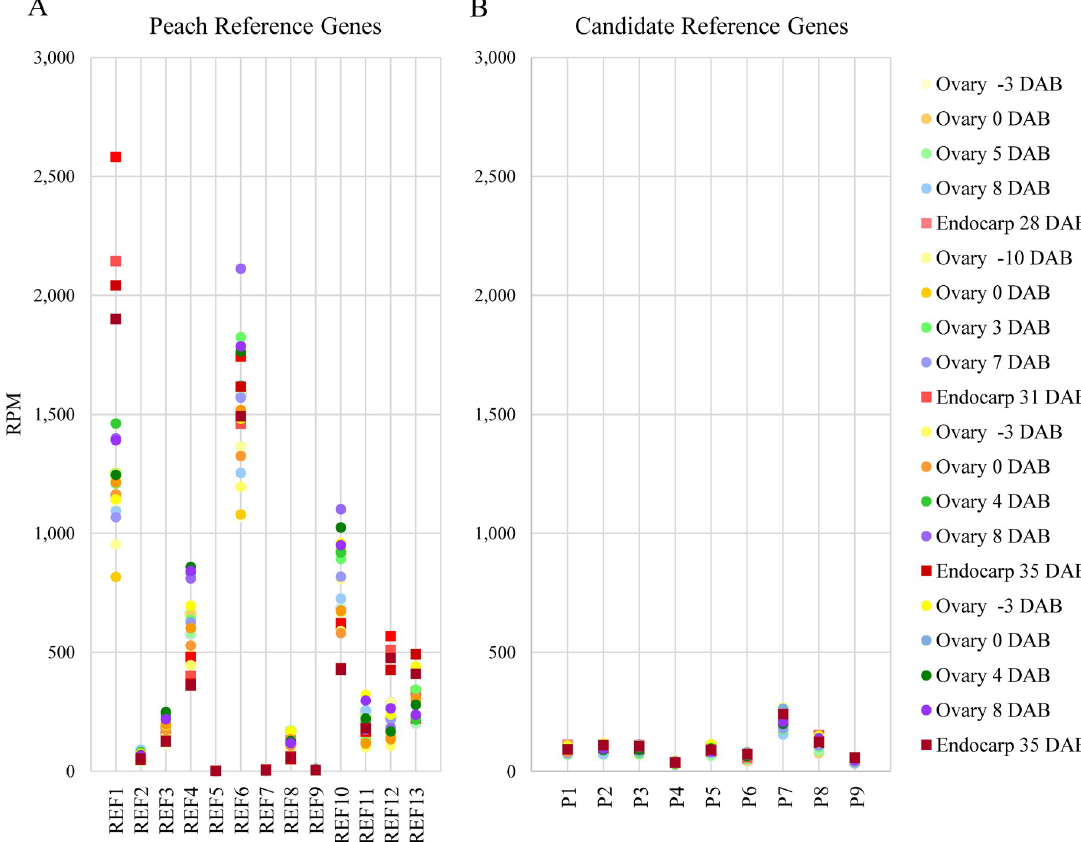
Fig 1. Comparison of reads per million (RPM) mapped to the peach genome between 13 previously identified reference genes [4] and nine candidate reference genes from plum early fruit libraries. A. Twenty RNAseq libraries were used to determine the RPMs for 13 predicted peach reference genes (REF1-REF13). Each library is represented by a specific color with endocarp tissues represented as squares and fruit/ovary tissues as circles. B. The same twenty RNAseq libraries were analyzed in the same manner as A but for nine candidate reference plum genes